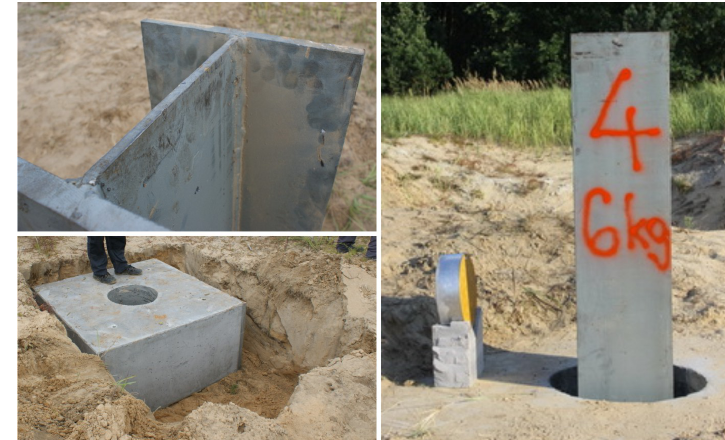
Figure 5. Pre-blast actual testing of the steel obstacle.